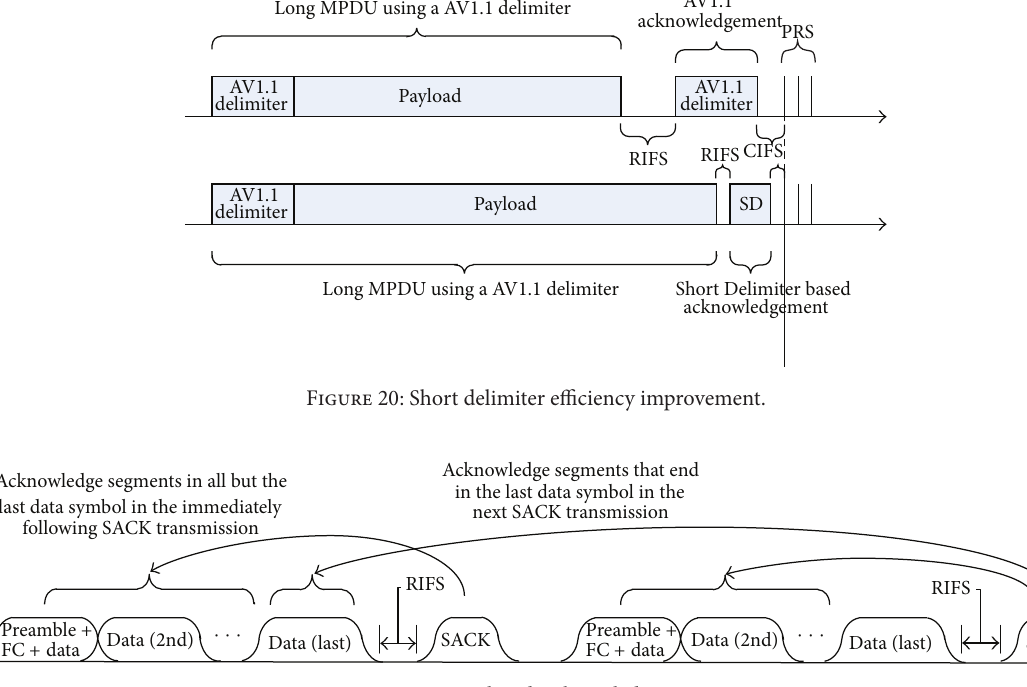
Figure 21: Delayed